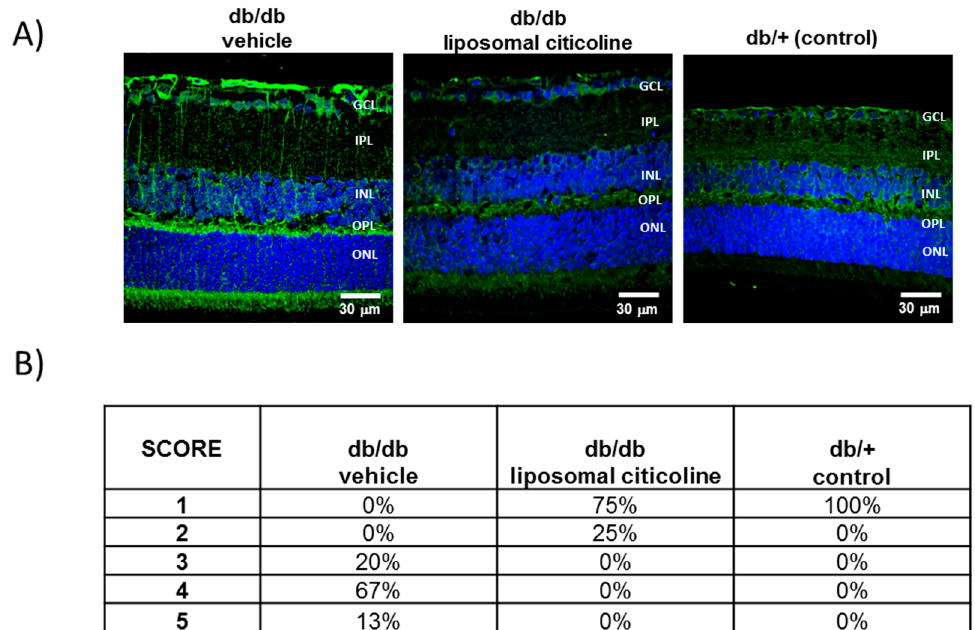
Figure 2. Effect of citicoline on glial activation. ( A ) Comparison of GFAP immunoreactivity (green) in the retina among representative samples from a diabetic mouse treated with vehicle, a diabetic mouse treated with citicoline, and a non ‐ diabetic mouse. Nuclei were labeled with Hoechst (blue). ONL: outer nuclear layer; OPL: outer plexifom layer; INL: inner nuclear layer; IPL: inner plexiform layer; GCL: ganglion cell layer. Scale bars, 30 μ m. ( B ) Quantification of glial activation based on the extent of GFAP staining. n = seven mice per group.